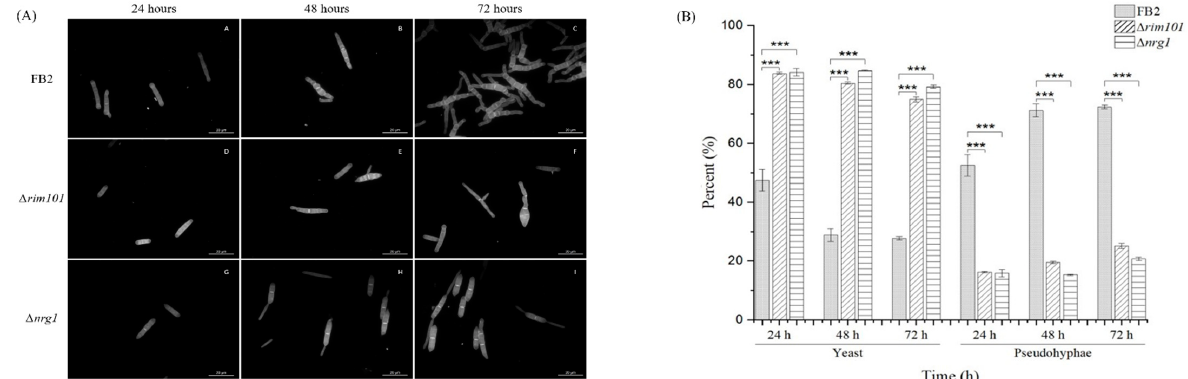
Figure 3. Growth of FB2, Δ rim101 and Δ nrg1 strains on MM (minimal liquid medium) pH 4. ( A ) Cells of WT, Δ rim101 and ∆ nrg1 ; strains were grown in MM pH 4 and analyzed for 72 h. ( B ) Yeast and pseudohyphae proportion, U. maydis wild-type (dotted bar), rim101 mutant (diagonal filled bar) and nrg1 mutant (vertical line bar) grown on MM (minimal liquid medium) pH 4. Bars represent the percentage of yeast and pseudohyphae at 24, 48 and 72 h. The growth morphology of each mutant strain was compared with the wild-type strain. The bar graph represents the mean ± SEM; *** p < 0.001. Tukey’s test was performed, and reliability used was 95%. Scale bar: 10 µm.